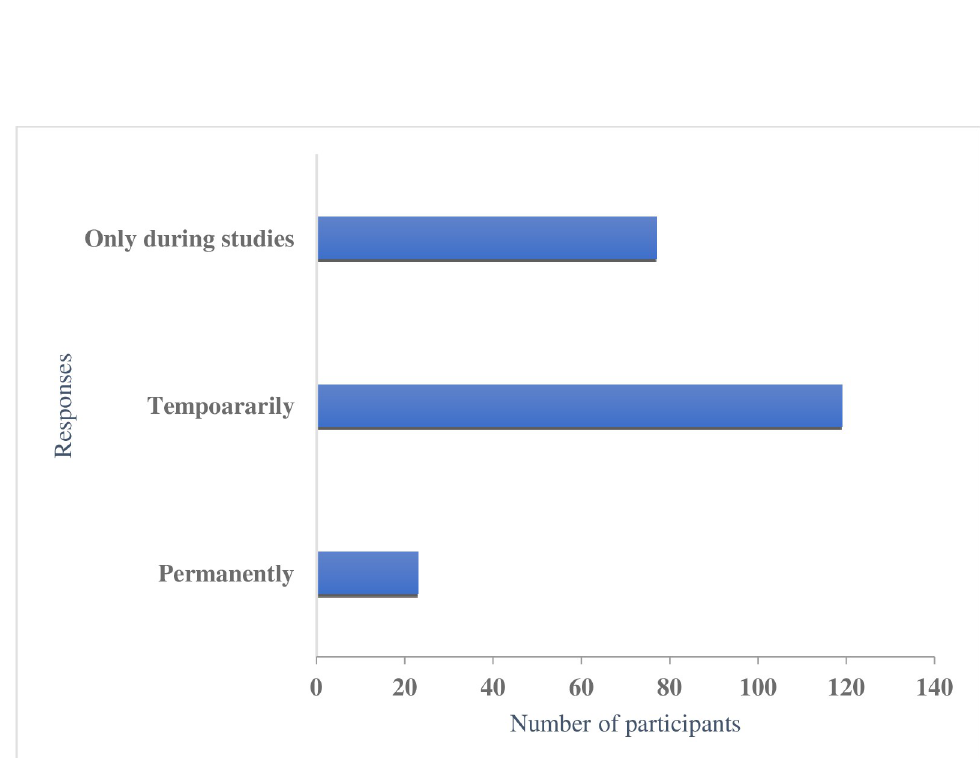
Fig 2. Students’ responses regarding staying in Australia after the completion of their